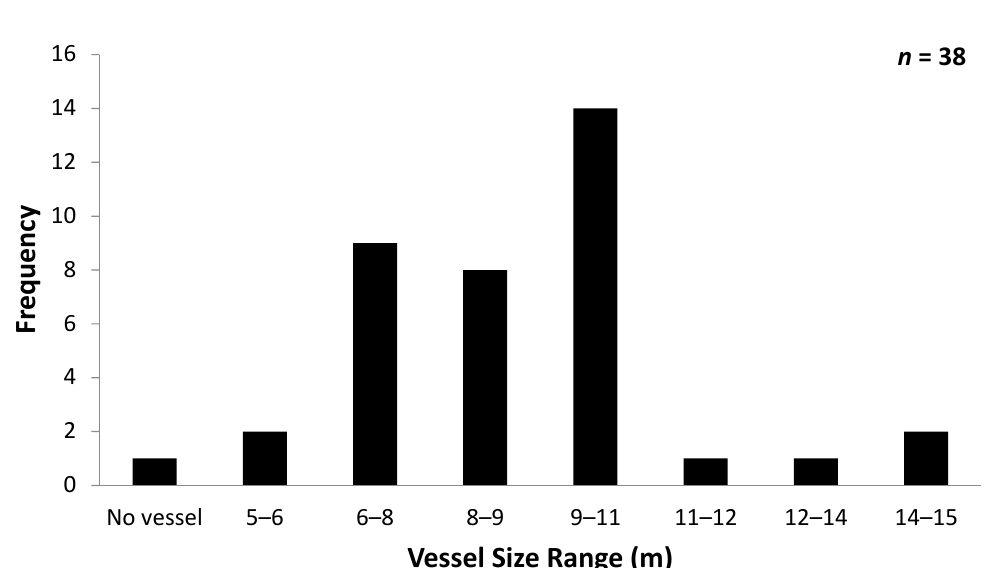
Figure 1. Mean vessel size range used by recreational anglers pursuing swordfish off Southeast Florida.